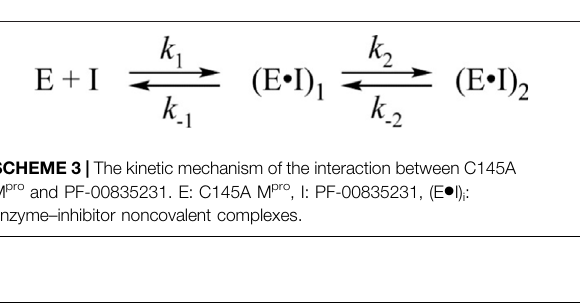
TABLE 3 | Rate constants for the interaction of WT M pro or C145A M pro with PF- 00835231.